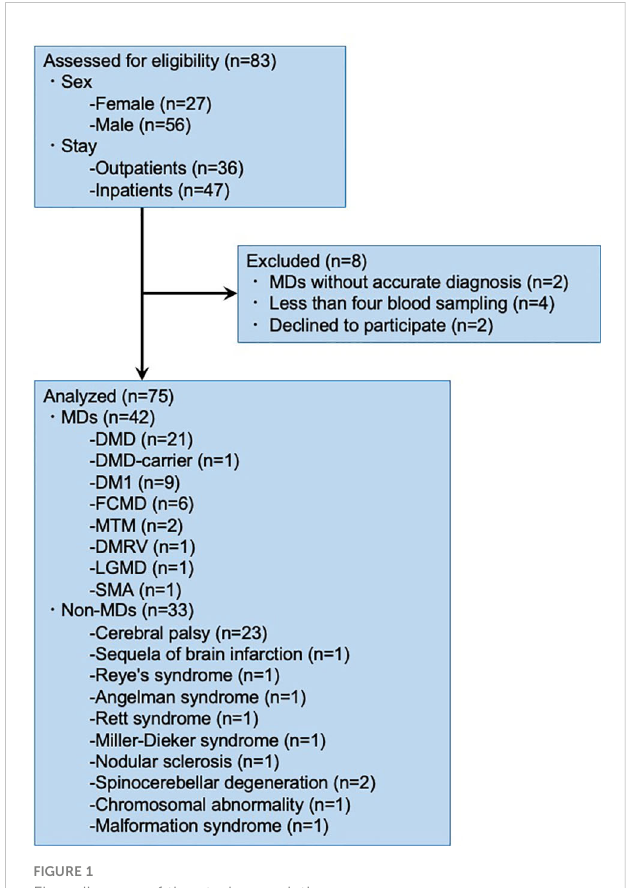
FIGURE 1 Flow diagram of the study